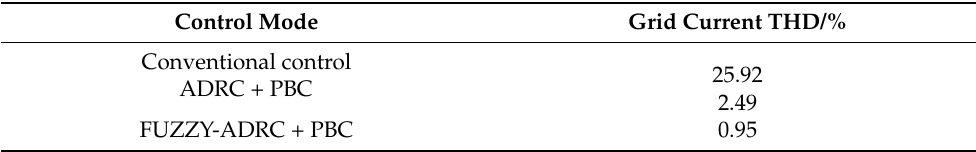
Table 4. THD analysis of grid - connected current under weak grid conditions